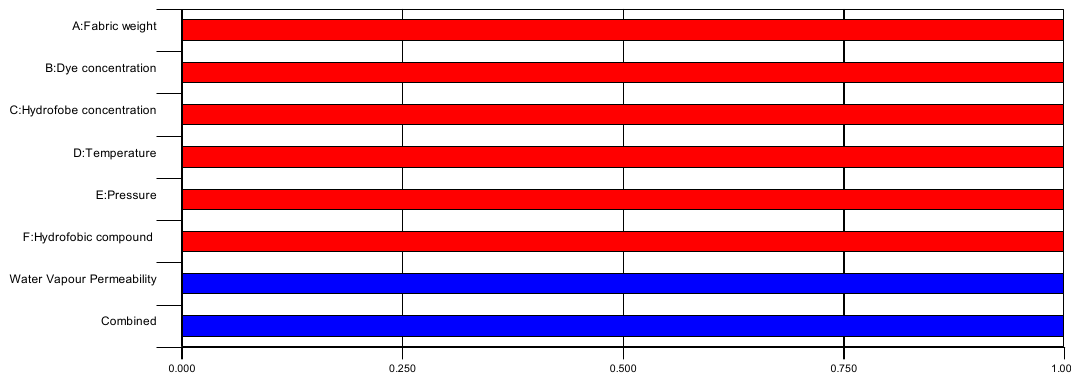
Figure 9. Desirability for each factor and each response individually for the optimal solution.